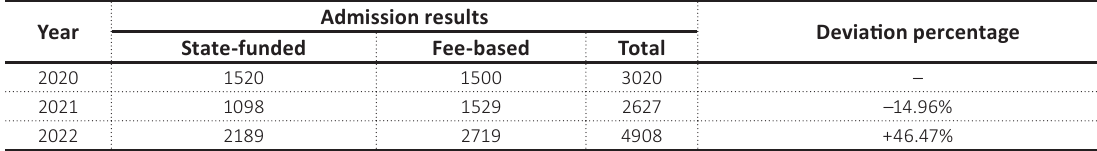
Table 1. Dynamics of increase in the number of applicants